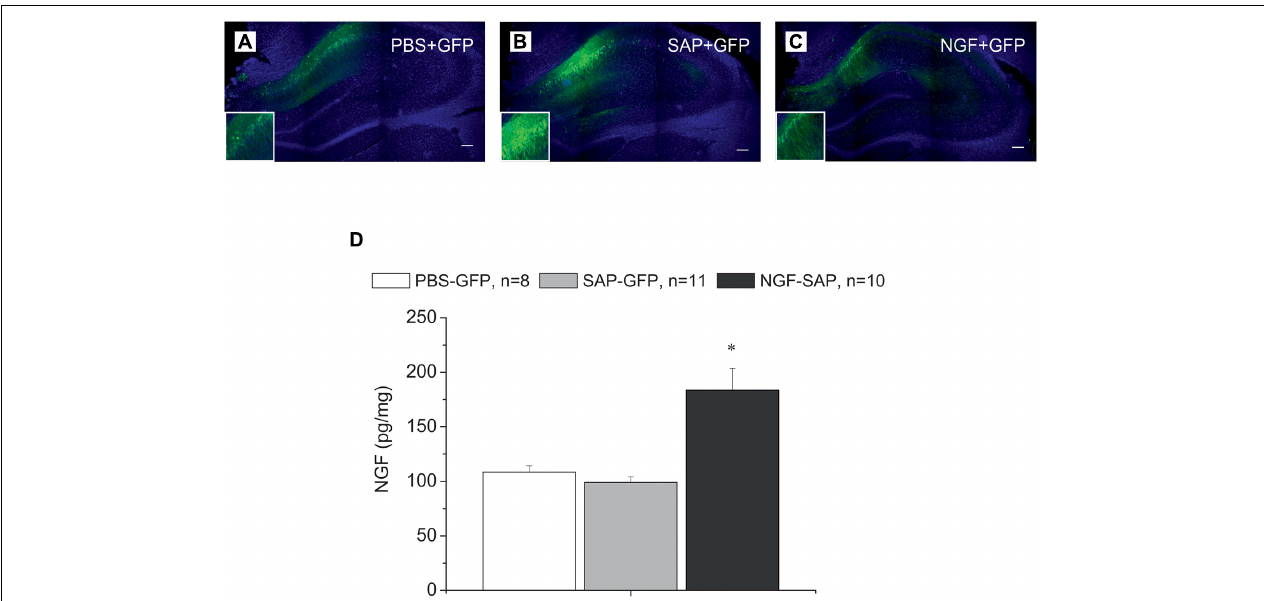
FIGURE 1 | Immunostaining of hippocampal slices with antibody against GFP and DAPI staining in the hippocampus control rats (A) and rats with cholinergic deficit (B,C) , which were transduced with AAV carrying either GFP alone (A,B) or NGF-IRES-GFP (C) . The images of GFP staining (green) are superimposed over images of the same sections stained with DAPI (blue). (D) Shows NGF protein concentration determined by ELISA in the hippocampi of control (PBS-GFP, n = 8), 192IgG-saporin (SAP-GFP, n = 11), and NGF overexpressed rats (SAP-NGF, n = 10). Each point represents the mean ± SEM. ∗ Significant differences compared to PBS-GFP and SAP-GFP groups, p < 0.05; bar, 200 µ